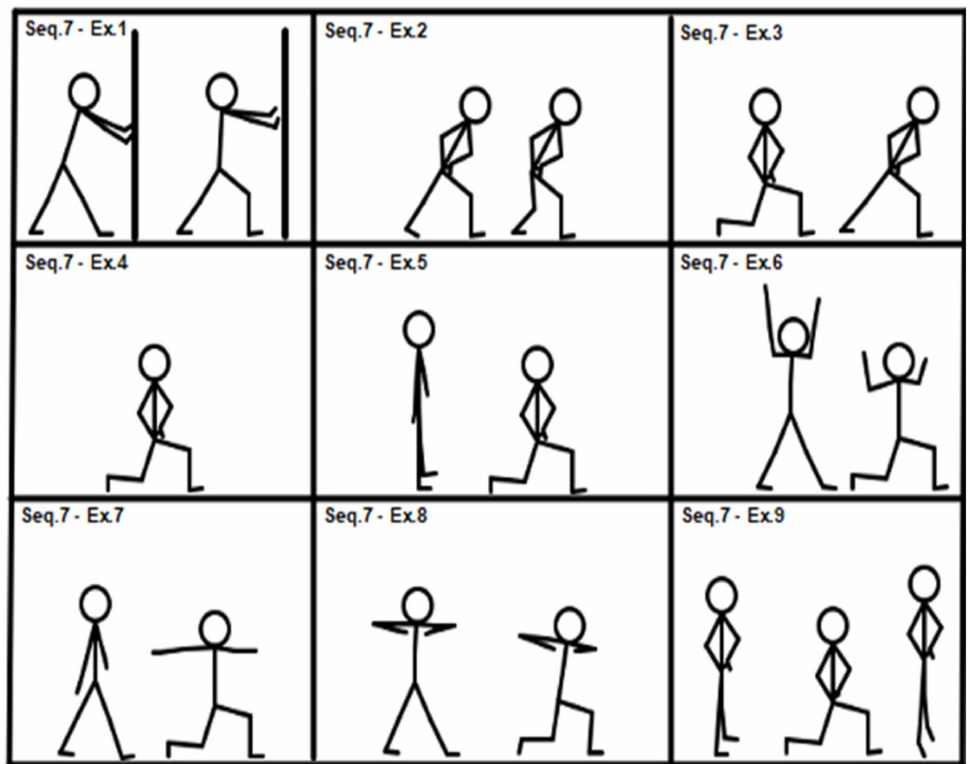
Figure 7. Sequence 7: lower limbs, high level.